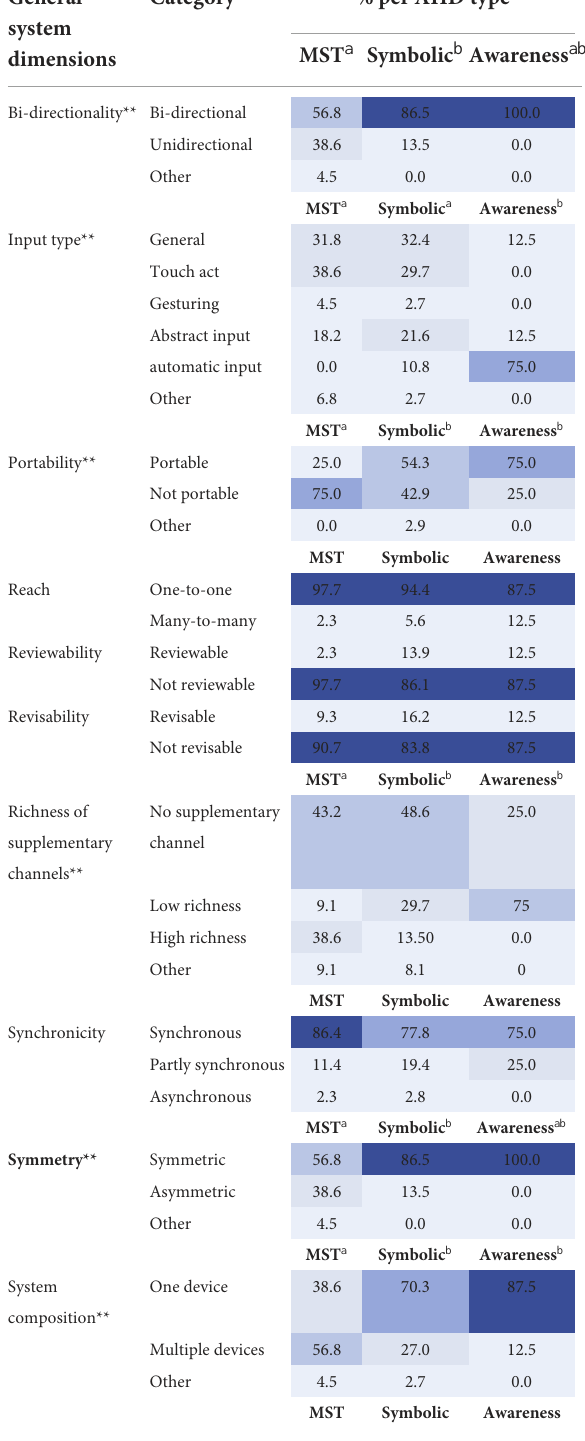
TABLE 2 Distribution of all 89 AHDs (in %) across the categories of each design dimension separated per AHD type: MST ( n = 44), symbolic ( n = 37), and awareness ( n =